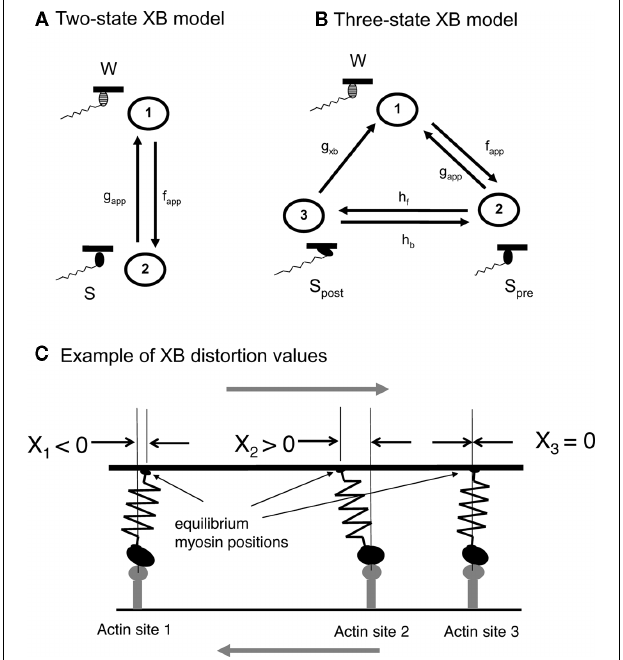
FIGURE 1 | Models of crossbridge attachment and definition of distortion. (A) A two-state model of XB cycling in which the upper state is assumed to be either detached or weakly bound (state 1), while the lower state is attached or strongly bound (state 2).The schematic descriptions show a functional unit with troponin/tropomyosin, associated seven actin units, and one nearby XB (see text for details). (B) A three-state model of XB cycling in which state 1 corresponds to detached/weakly bound, state 2 represents strongly bound and pre-rotated, and state 3 represents strongly bound and post-rotated.The transition rates between states are bidirectional, except for the transition rate g XB between state 3 and 1 that correspond to the release of ADP and the binding of ATP, so that reverse rate is essentially zero. (C) Schematic diagram shows examples of crossbridge distortion values.The myosin heads are assumed to bind to actin sites and generate force that is directly proportional to the distortion defined as the distance from the equilibrium position to the actin site in the direction parallel to the filaments (the example shows X 2 > X 3 > X 1 ). Muscle shortening causes motions of the thick and thin filaments that are shown by the gray arrows, such that distortion values decrease with time (i.e., dX n / dt < 0 for n = 1, 2, 3,